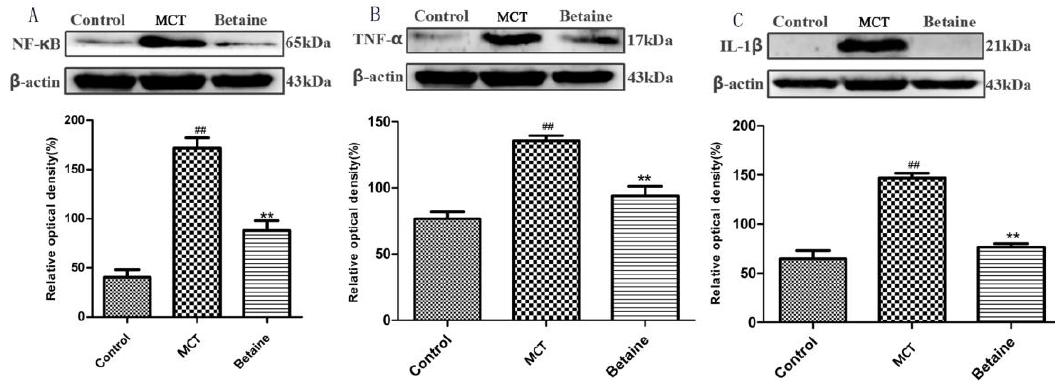
Figure 9. ( A – C ) Effects of betaine on the protein expression of nuclear factor- κ B (NF- κ B), tumor necrosis factor alpha (TNF- α ) and interleukin-1 β (IL-1 β ) assessed by Western blot. Representative western blot band and expression of protein level of ( A ) NF- κ B, ( B ) TNF- α and ( C ) IL-1 β ; β -actin was used for normalization. Data are shown as mean ± standard error of the mean ( n = 6). ## p < 0.01 vs control group; ** p < 0.01 vs MCT group.